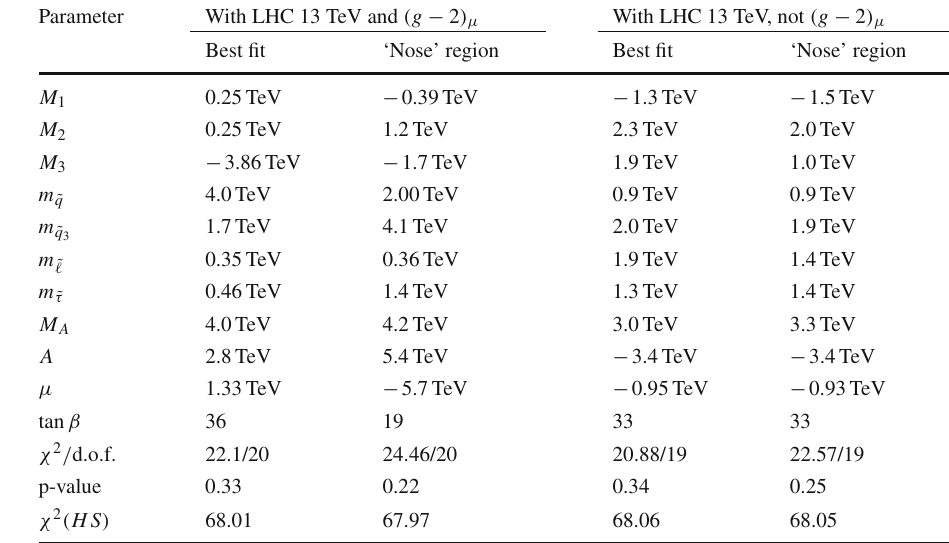
Table 4 Values of the pMSSM11 input parameters and values of the global χ 2 function at the best-fit points including the LHC 13-TeV constraints, with and without the ( g − 2 ) μ constraint, as well as at representative points in the ‘nose’ regions in the top left and right panels of Fig. 2. Lower rows show the total χ 2 /